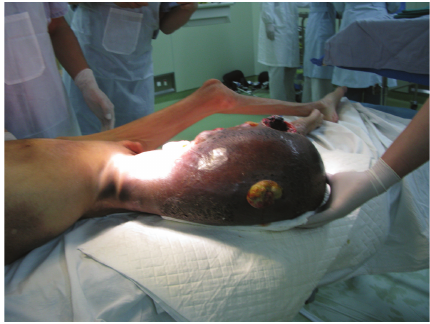
Figure 3: Inflammatory cell infiltration, formation of folliculus lymphaticus, muscular fiber breakage, and fibrous tissue hyperplasy were seen in inflammatory pseudotumour. HE × 40.